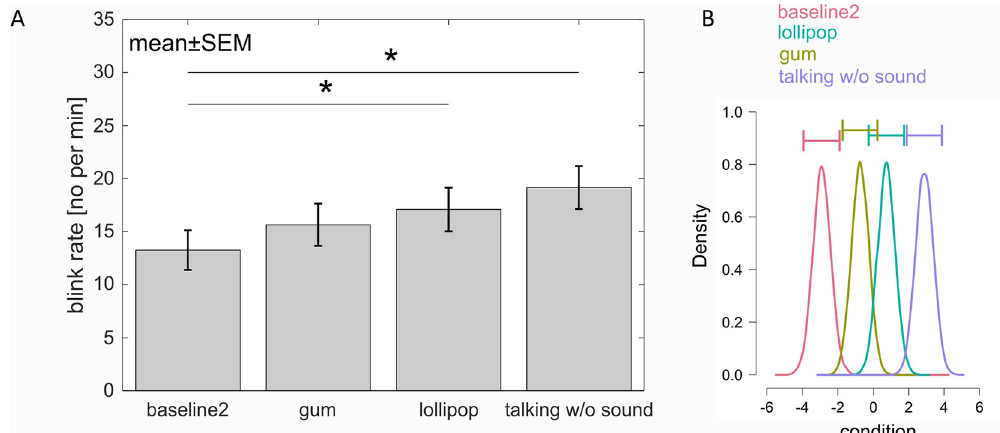
Fig 3. Influence of motor tasks on the blink rate. A. Blink rate during the second baseline (being at rest), moving the lips during lollipop sucking, moving jaw muscles during gum chewing and talking without sound production. Error bars represent one SEM. Stars mark significant differences revealed by parametrical statistics. B. Posterior distributions of the effect of each condition on the blink rate. Talking without sound has highest effect on blink rate followed by lip movement during lollipop sucking, jaw movement during gum chewing and baseline. The horizontal error bars above each density represent 95% credible intervals.